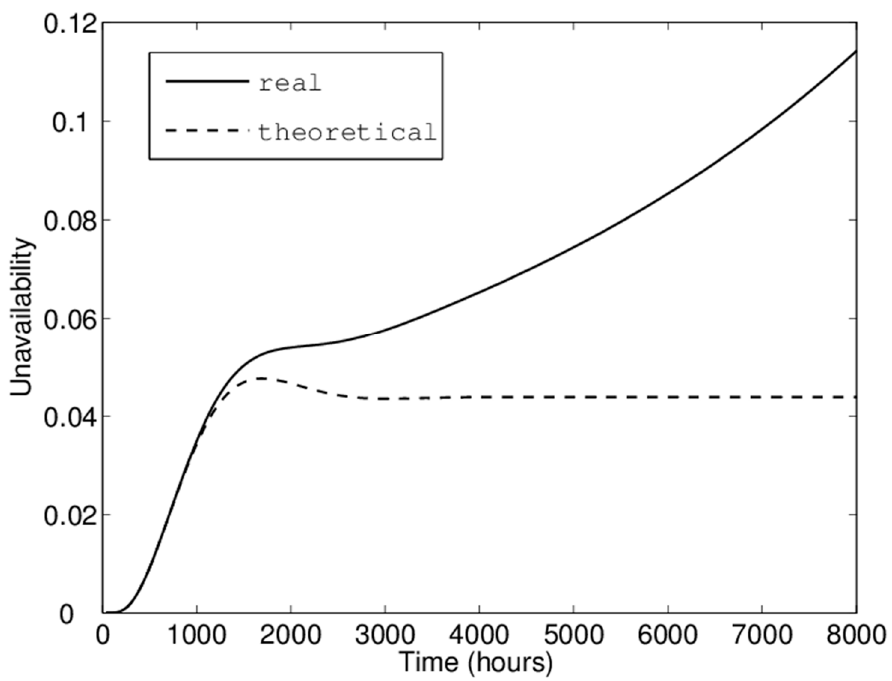
Figure 7. Theoretical versus real ( q a = 1.25) ageing of the four-component system.